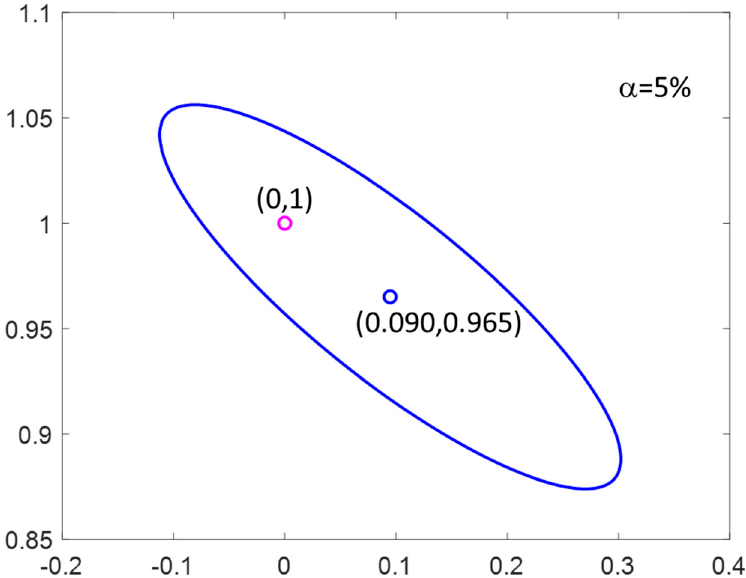
Figure 6. Joint confidence interval for the intercept and the slope of the comparison between the SCiO and NeoSpectra PLS best predictions.